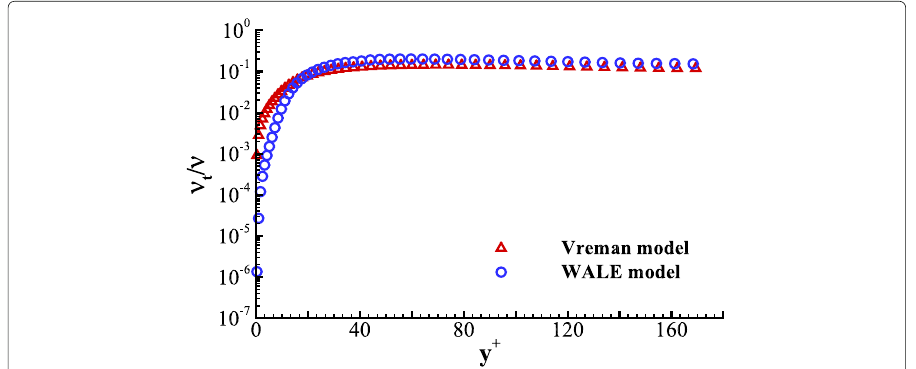
Fig. 7 The ν t /ν in the near wall region for the fully developed turbulent channel